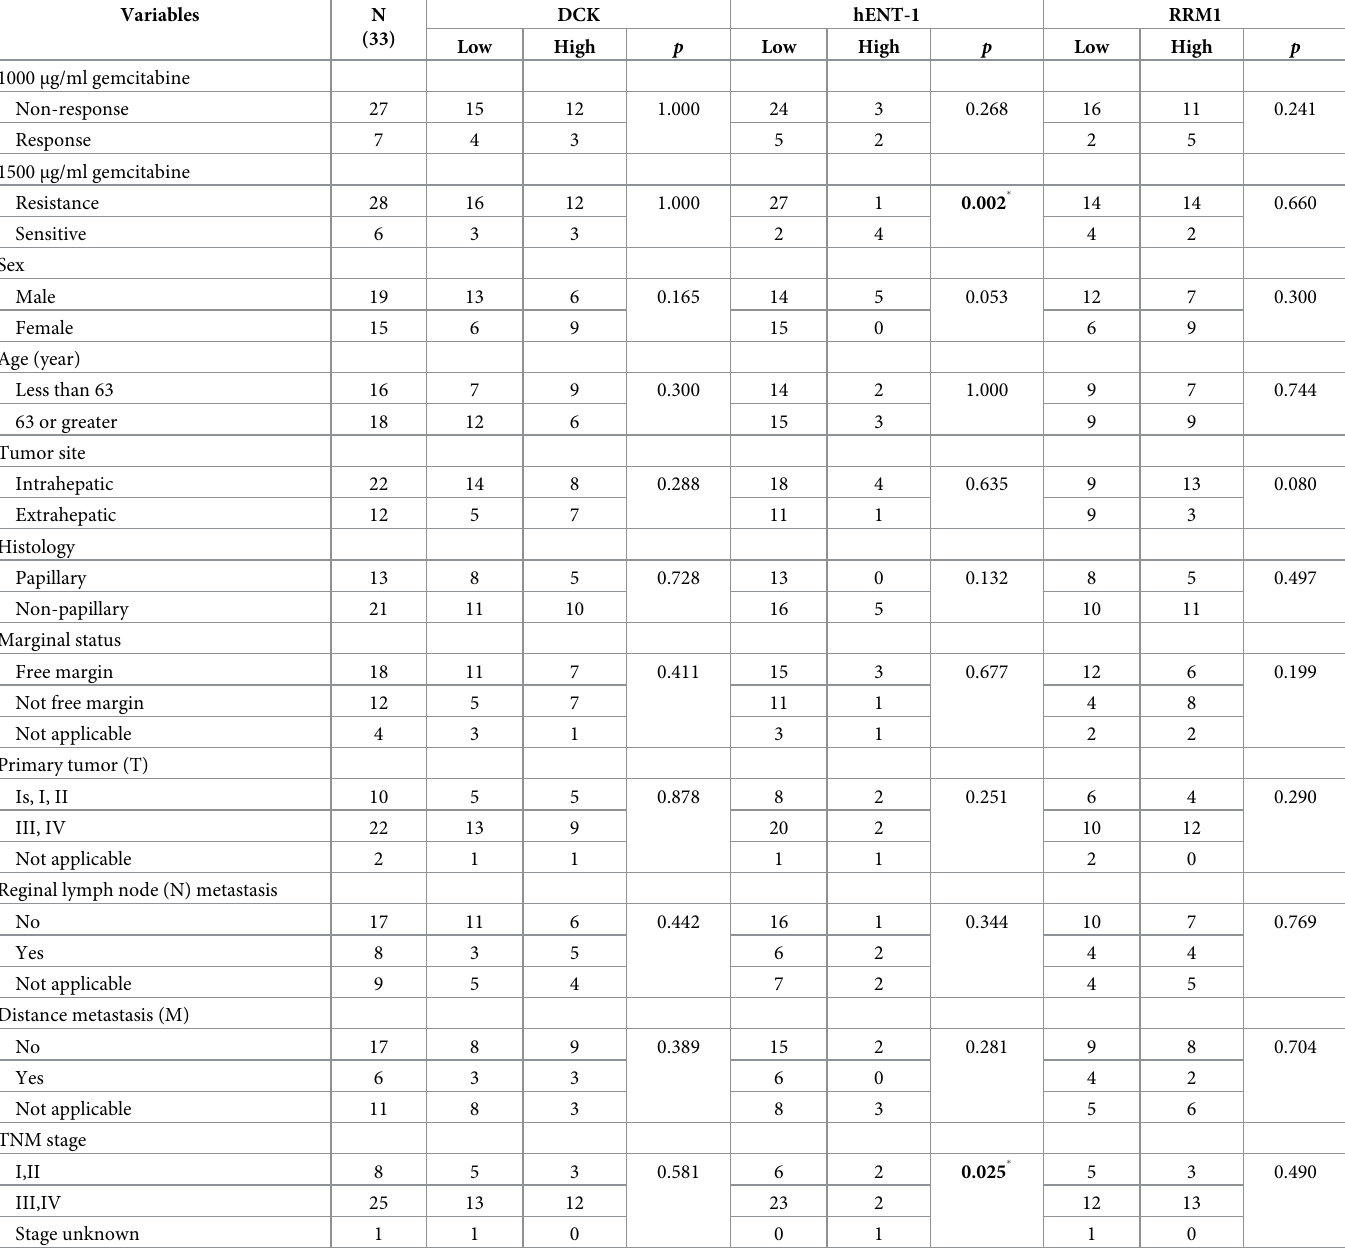
Table 5. Correlation of the expression of DCK, hENT-1 and RRM-1 with the drug response pattern using HDRA and the clinicopathological data of CCA patients. Variables N